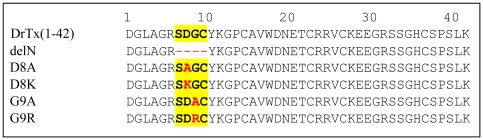
Sequence alignment of DrTx(1-42) and its mutants.The N-turn region derived from BmKITc is shadowed in yellow. Mutated sites are indicated in red.